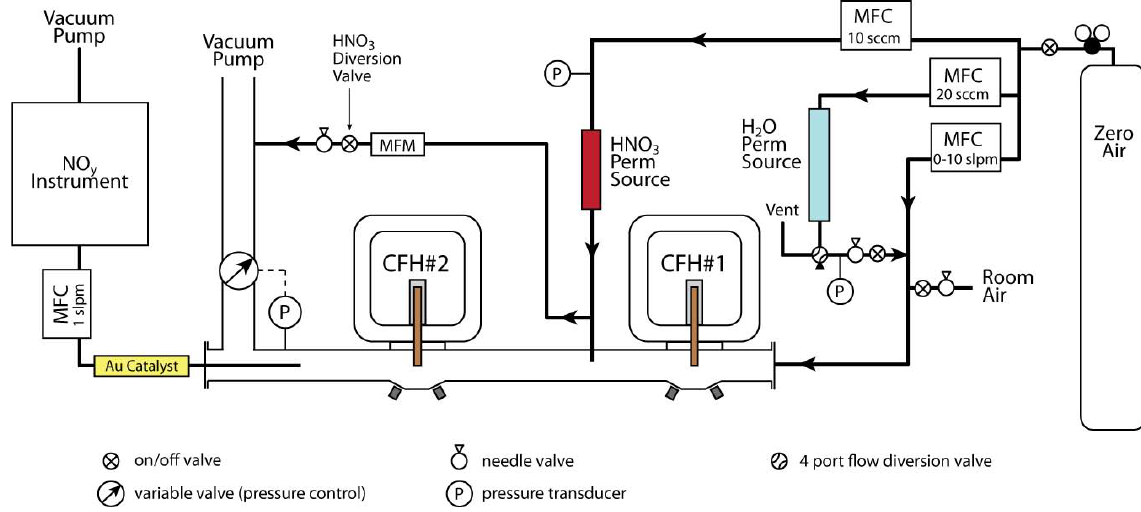
Fig. 2. Experimental set-up for the HNO 3 -frost point tests showing the arrangement in the manifold of the hygrometer mirrors, HNO 3 addition point, and NO y sampling inlet. MFC is a mass flow controller operating at the specified flow or within the given flow range; MFM is a mass flow meter. Drawing not to